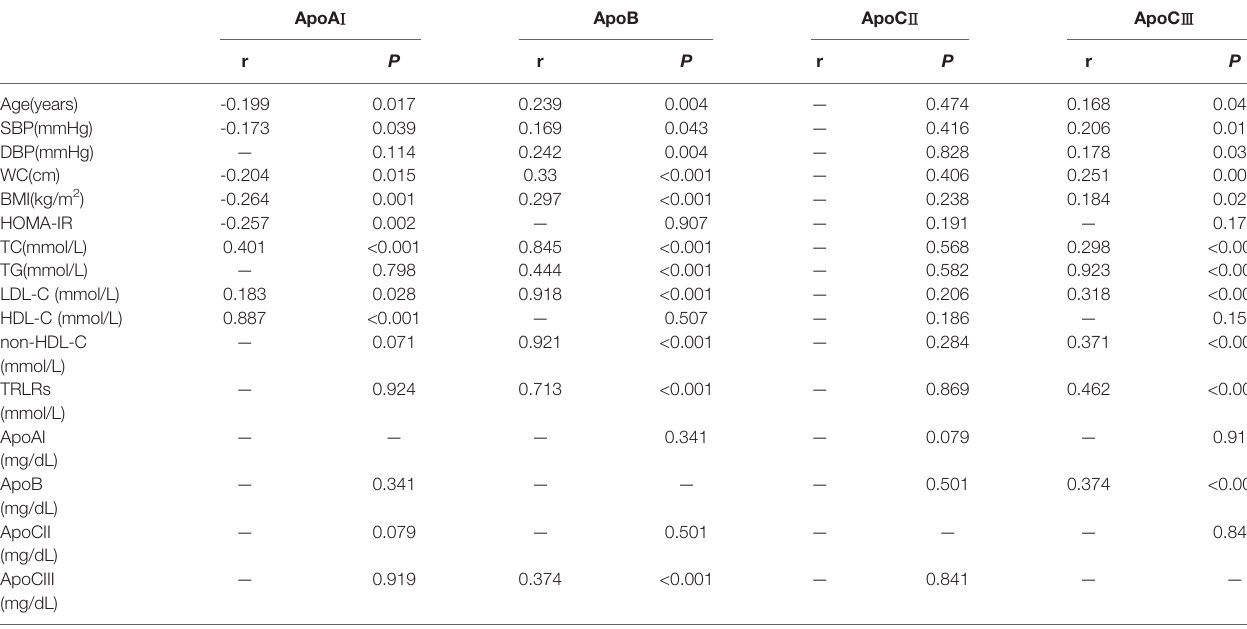
TABLE 3 | Correlation of fasting apolipoprotein levels and other